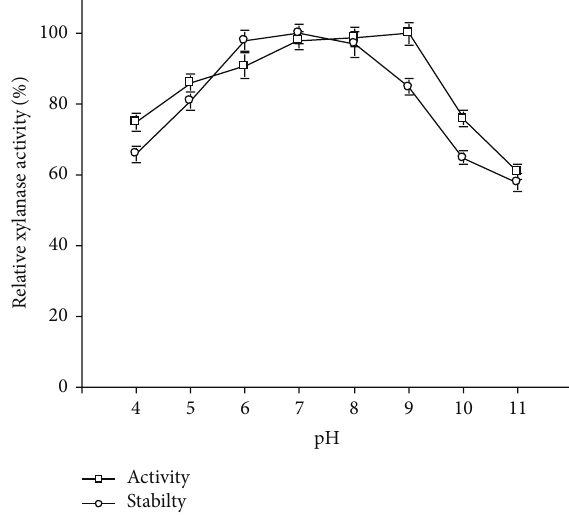
Figure 5: Effect of pH on activity and stability of crude xylanase preparation of strain X1.